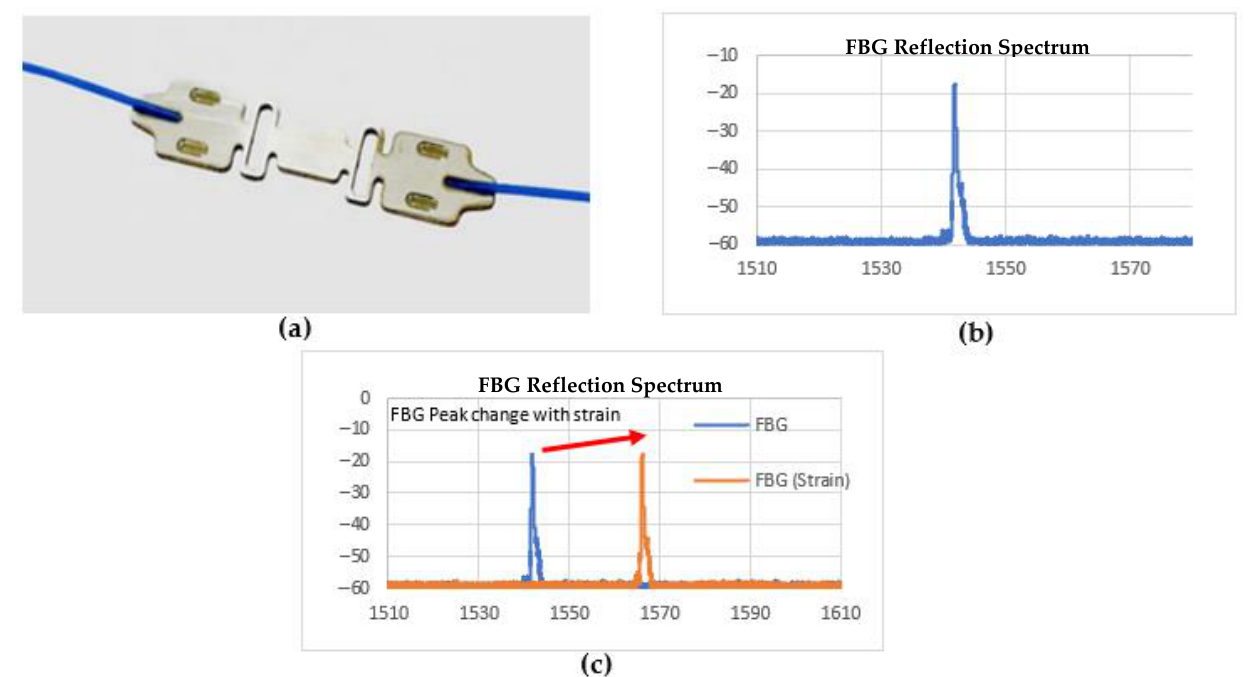
Figure 2. ( a ) Aurora TM FBG integrated strain sensor, ( b ) FBG Reflection Spectrum, ( c ) FBG peak change with strain change.